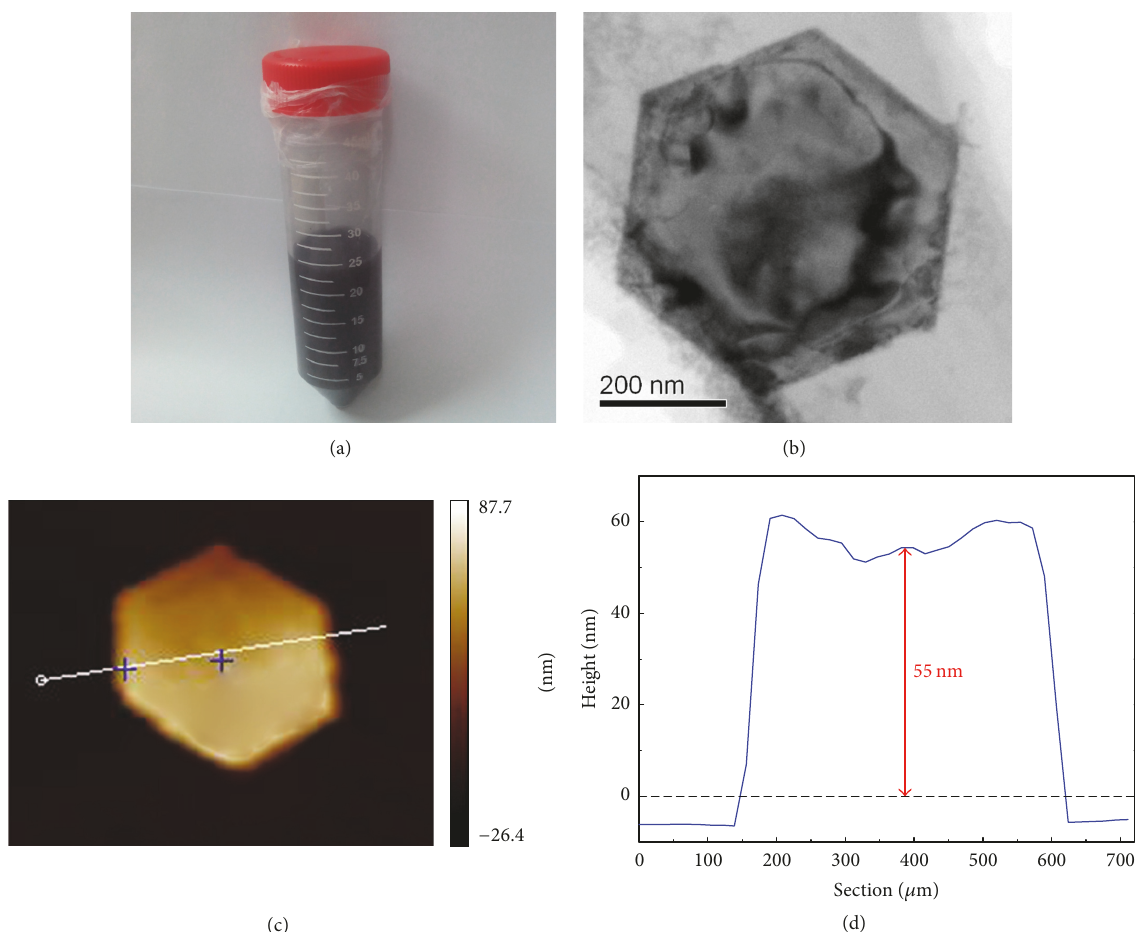
Figure 4: (a) The physical photo of TI: Bi 2 Te 3 ethanol solution, (b) TEM images, (c) AFM images, and height profiles of the as-prepared few-layer TI: Bi 2 Te 3